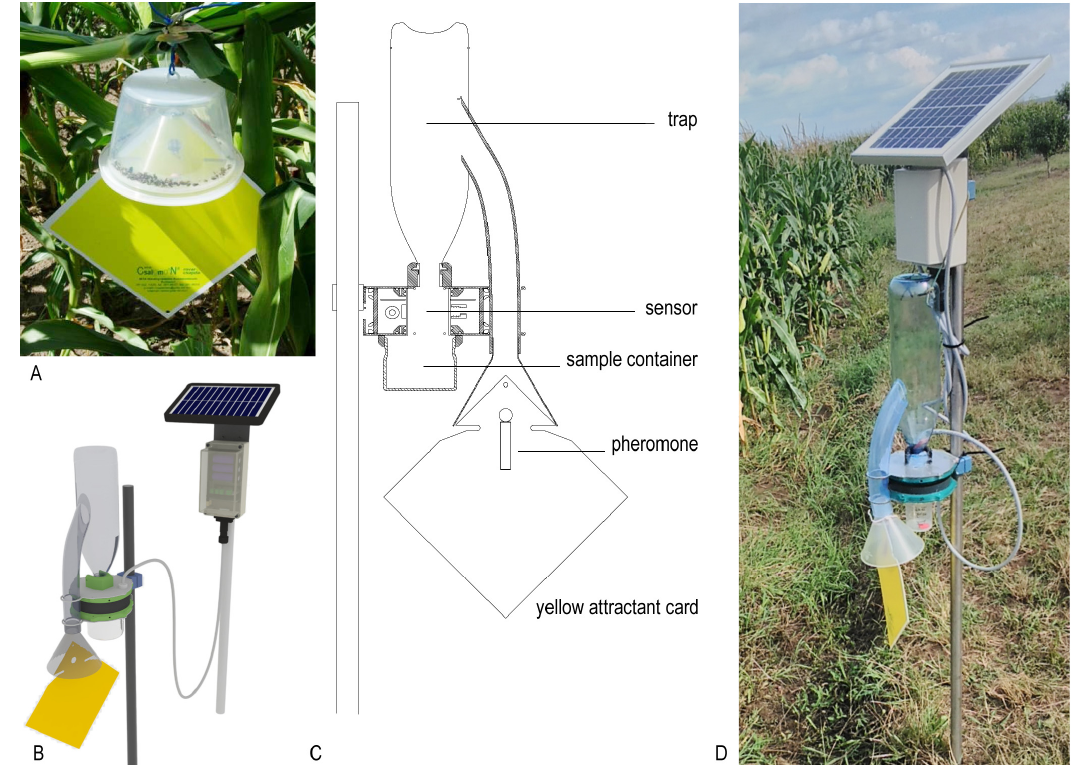
Figure 1. Construction of the new ZooLog KLP probe. ( A ): the original CSALOMON ® KLP “hat” trap. Western corn rootworm (WCR) individuals are attracted by pheromone towards an inverted funnel, from where they cannot escape. ( B , C ): the design and cross section of the new probe. The yellow attractant card and the inverted funnel are connected to a PET bottle, from where WCR individuals fall through the sensor-ring into the sampling container. Detection data are transferred to the central database via the internet. A solar panel provides power for the electronics, enabling online monitoring throughout the season. ( D ): The new probe deployed adjacent to the test cornfield.